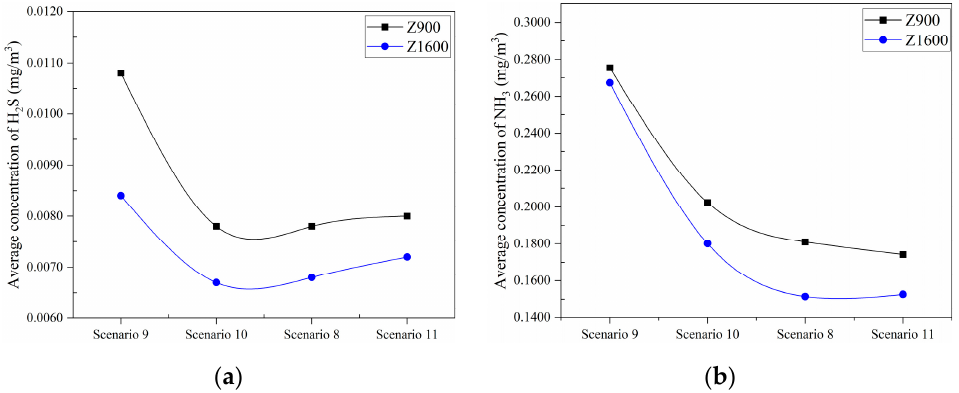
Figure 10. Variation trend in the ACIPs with supply-air vent velocities. ( a )Average concentration of H 2 S; ( b )Average concentration of NH 3 .